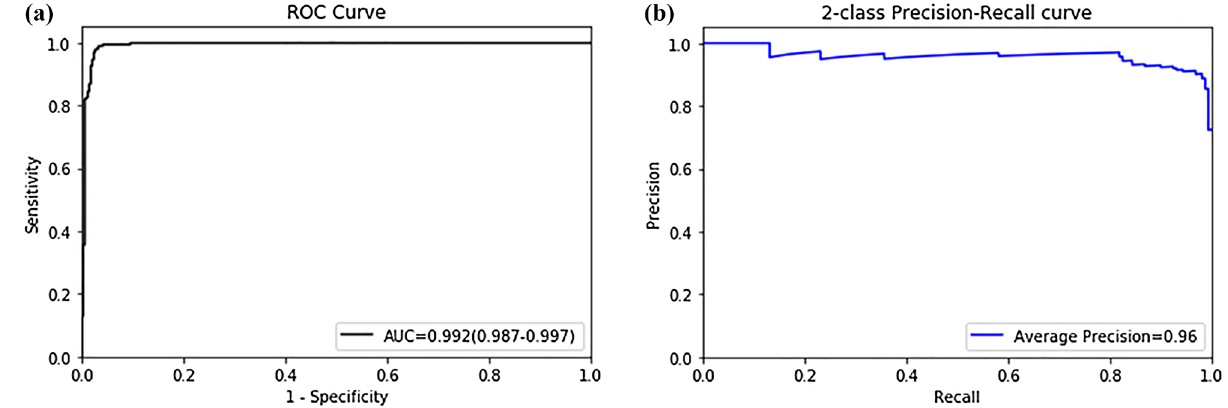
Figure 1. Receiver operating characteristic curve ( a ) and precision–recall curve ( b ) of LTP classification model.